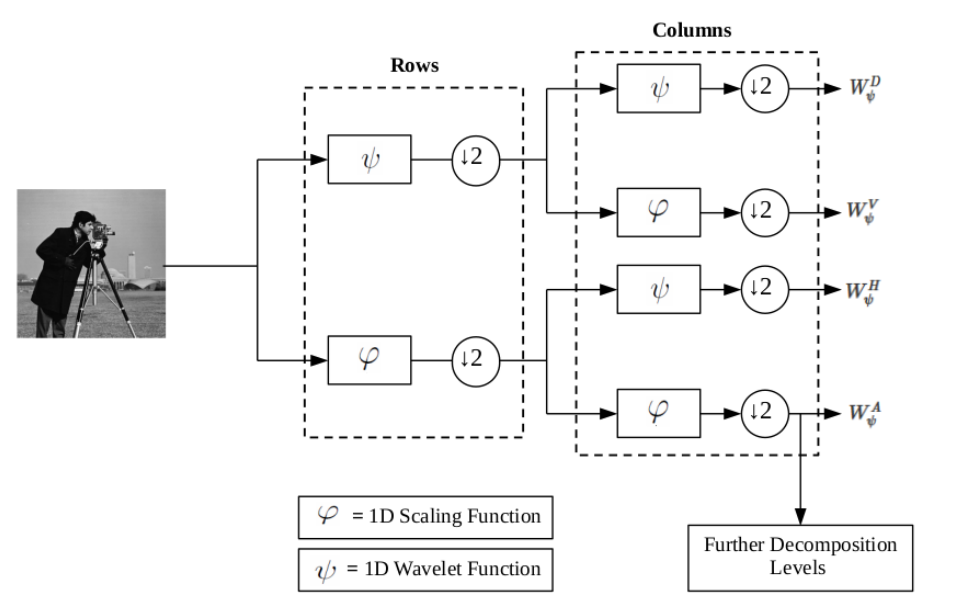
Figure 2. Application of wavelet decomposition to I ( x , y )